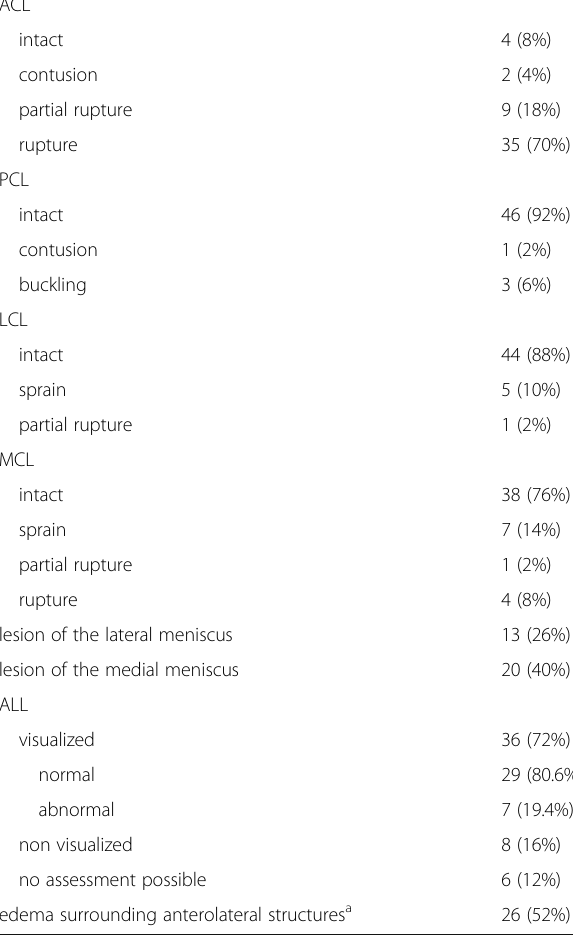
Table 4 Physical examination in 52 patients suspected for ACL injury with a positive and negative TIR test